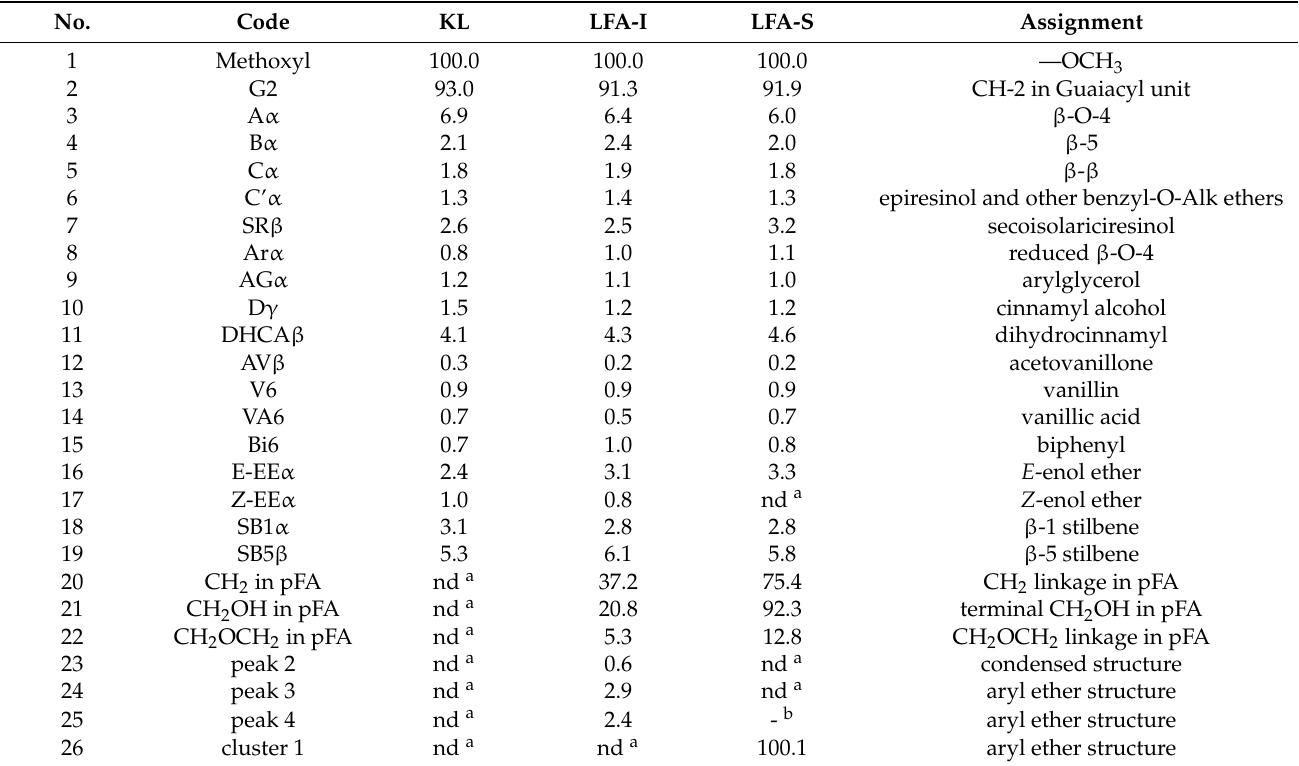
Table 2. Tentative assignment of main KL signals and some new signals in the spectra of LFA fractions